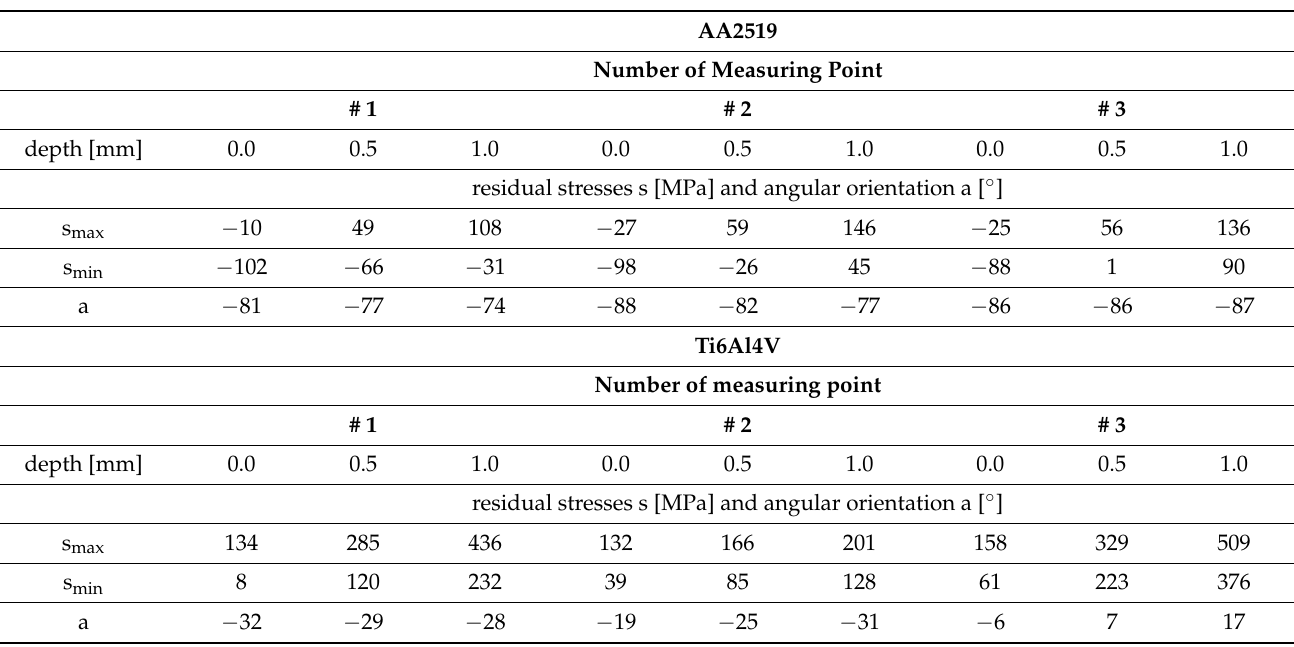
Table 4. The results of residual stresses measurements of the heat treated laminate AA2519-Ti6Al4V laminate with interlayer of AA1050.